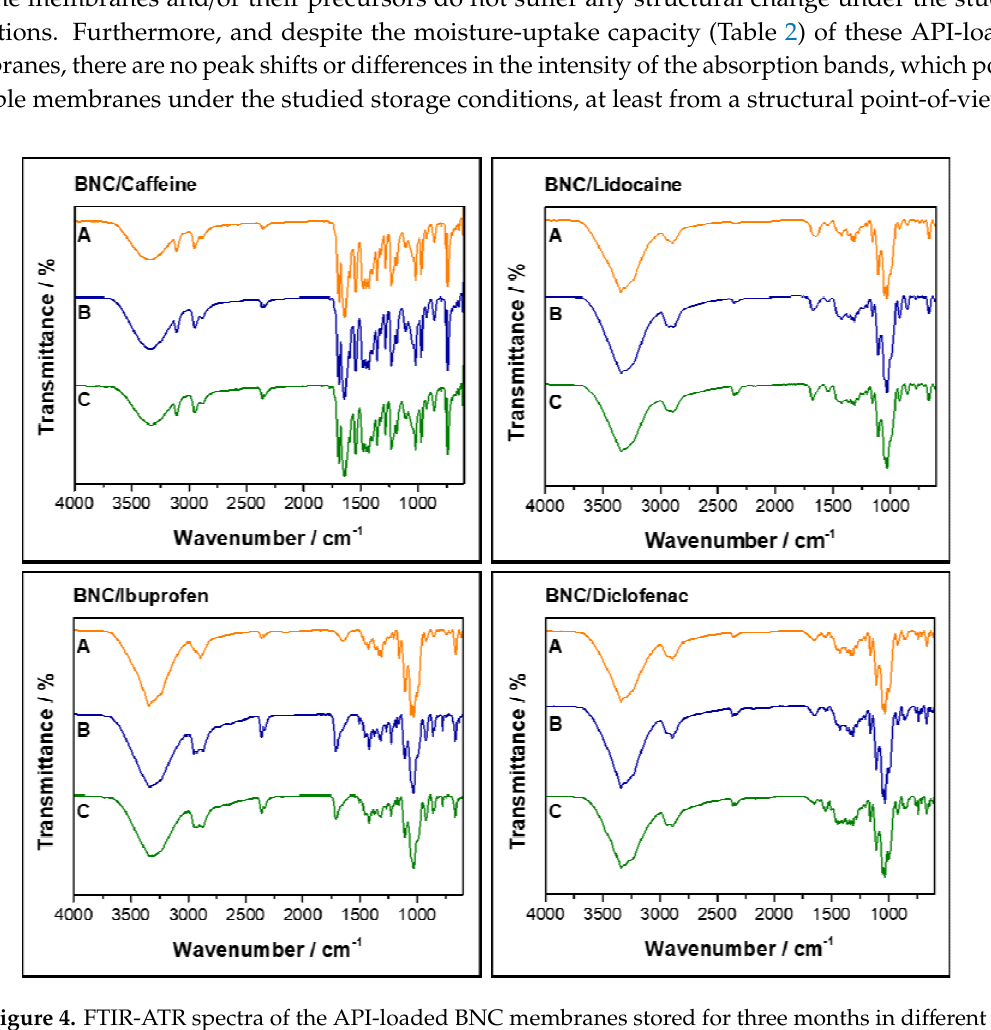
Figure 4. FTIR-ATR spectra of the API-loaded BNC membranes stored for three months in di ff erent Figure 4. FTIR ‐ ATR spectra of the API ‐ loaded BNC membranes stored for three months in different conditions: (A) 75% RH at 40 ◦ C, (B) 60% RH at 25 ◦ C and (C) 0% RH at 40 ◦ conditions: (A) 75% RH at 40 °C, (B) 60% RH at 25 °C and (C) 0% RH at 40 °C.